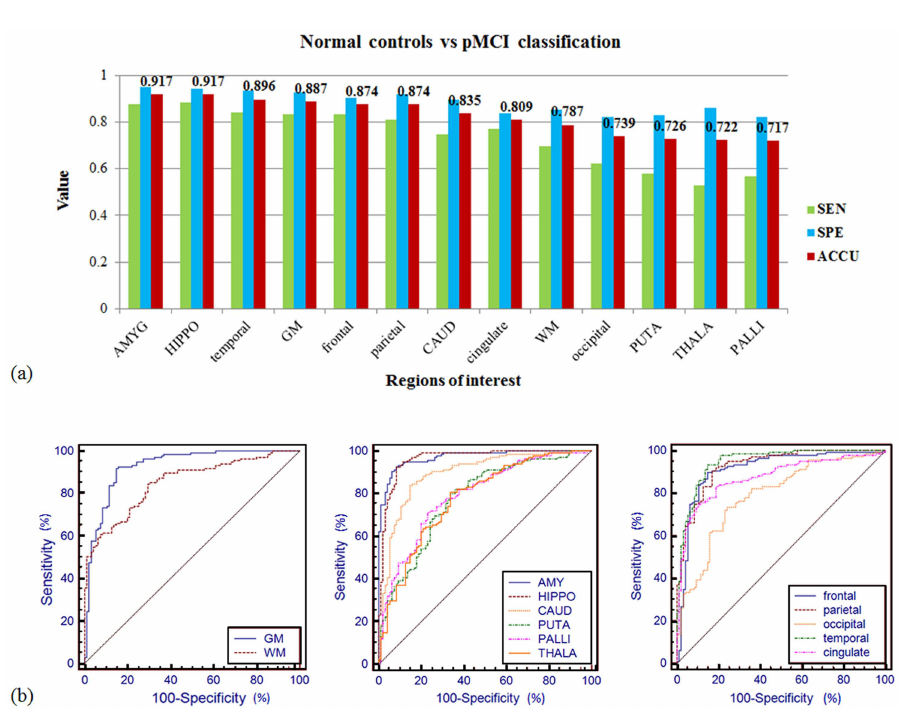
Fig 4. (a) Classification sensitivity (green), specificity (blue), and accuracy (red) of normal elderly controls versus progressive MCI subjectswith different ROIs. Using the amygdala,and hippocampus as ROI, the algorithmobtainedclassification accuracy of 91.74%. With the other six ROIs (temporal, GM, frontal, parietal, caudate, and cingulate), the accuracy exceeded80%. (b) The ROC curve of the prediction accuracy